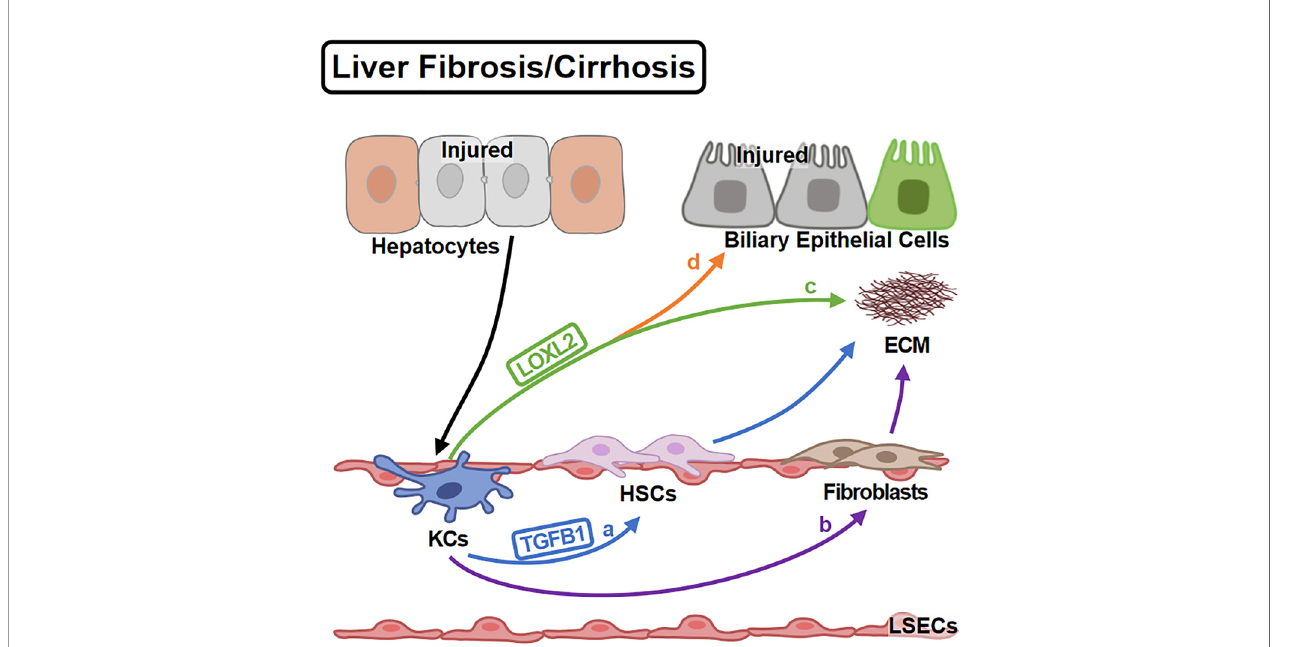
FIGURE 4 | KCs in Liver Fibrosis/Cirrhosis. Liver fi brosis is the over-repair in chronic liver injury. KCs are activated by injured hepatocytes and promote fi brosis in different ways: (A) KCs promote HSC activation via TGFB1. (B) KCs themselves can differentiate into fi broblasts contributing to ECM deposition. On the other hand, (C) KCs mediate the cross-linking of collagen via LOXL2. (D) KCs also induce the impairment of biliary epithelial cells by LOXL2.